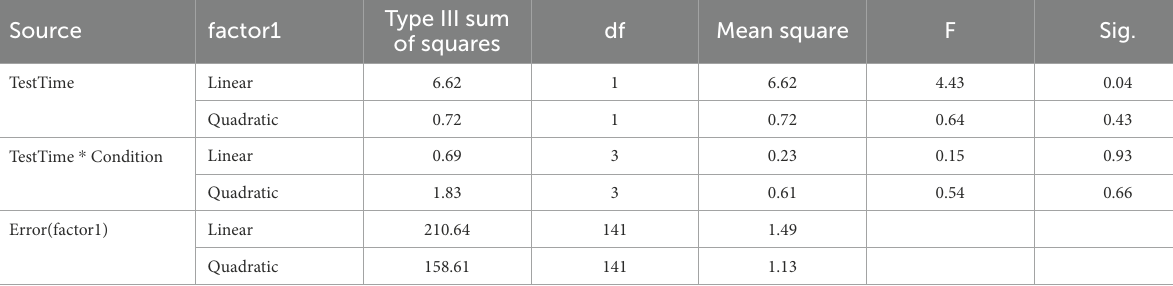
TABLE 9 Butterfly Game – ANOVA results of post and followup play.